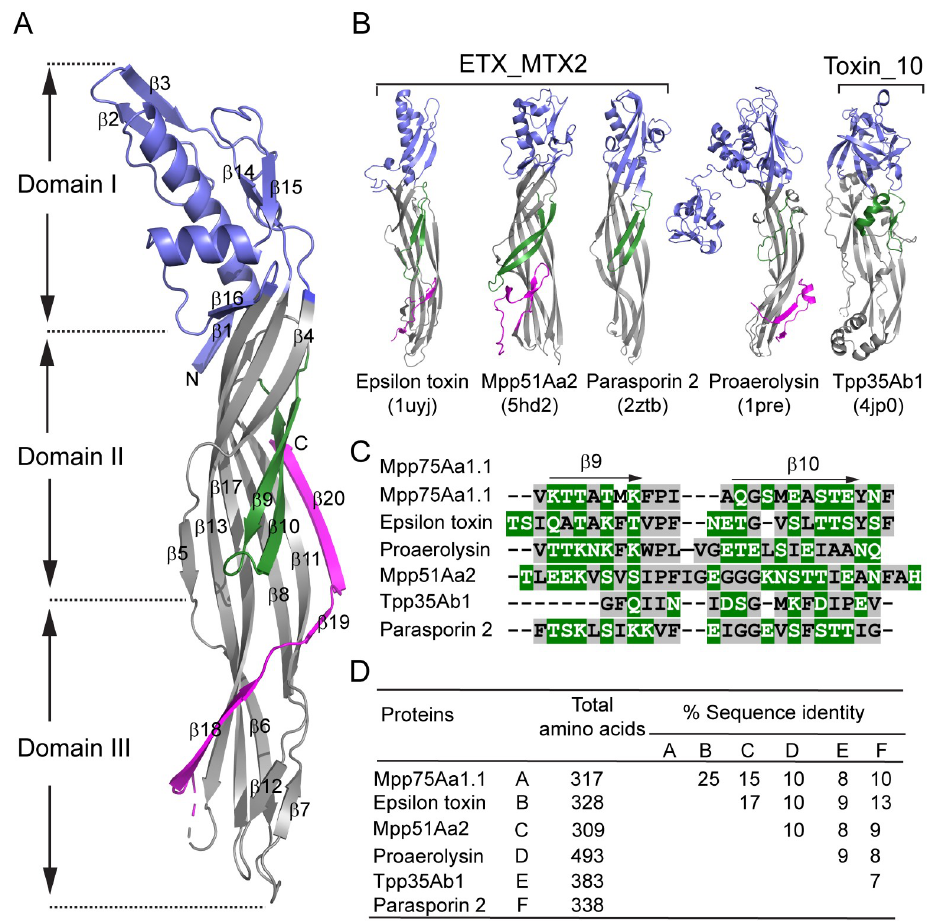
Fig 1. Structural and evolutionary properties of Brevibacillus laterosporus Mpp75Aa1.1, an ETX_MTX2 β -pore- forming protein. (A) Cartoon representation of the Mpp75Aa1.1 crystal structure. Domain I, the transmembrane pore-forming β -hairpin, and the carboxyl-terminal peptide, are colored in slate, green, and magenta, respectively. (B) Structural comparison of related β -PFPs Mpp51Aa2, Parasporin 2, Epsilon toxin, Proaerolysin, and Tpp35Ab1. All structural cartoons were rendered using PyMOL ™ 2.0.2–Copyright. (C) Multiple sequence alignment (CLUSTAL W) of the transmembrane β -pore forming hairpin from Mpp75Aa1.1 and selected β -PFPs. Alternate hydrophobic (grey) and hydrophilic (green) amino acid residues are shown. (D) Pairwise amino acid sequence alignments of Mpp75Aa1.1 and selected β -PFPs. Alignments were obtained using CLCBio ™ version 7.6.4. Primary amino acid sequences used are from Mpp75Aa1.1 (ASY04853.1), Epsilon toxin (AAA23235.1), Mpp51Aa2 (ADK94873.1), Parasporin 2 (BAC79010.1), Proaerolysin (WP_098980947.1), and Tpp35Ab1 (AAG41672.1).